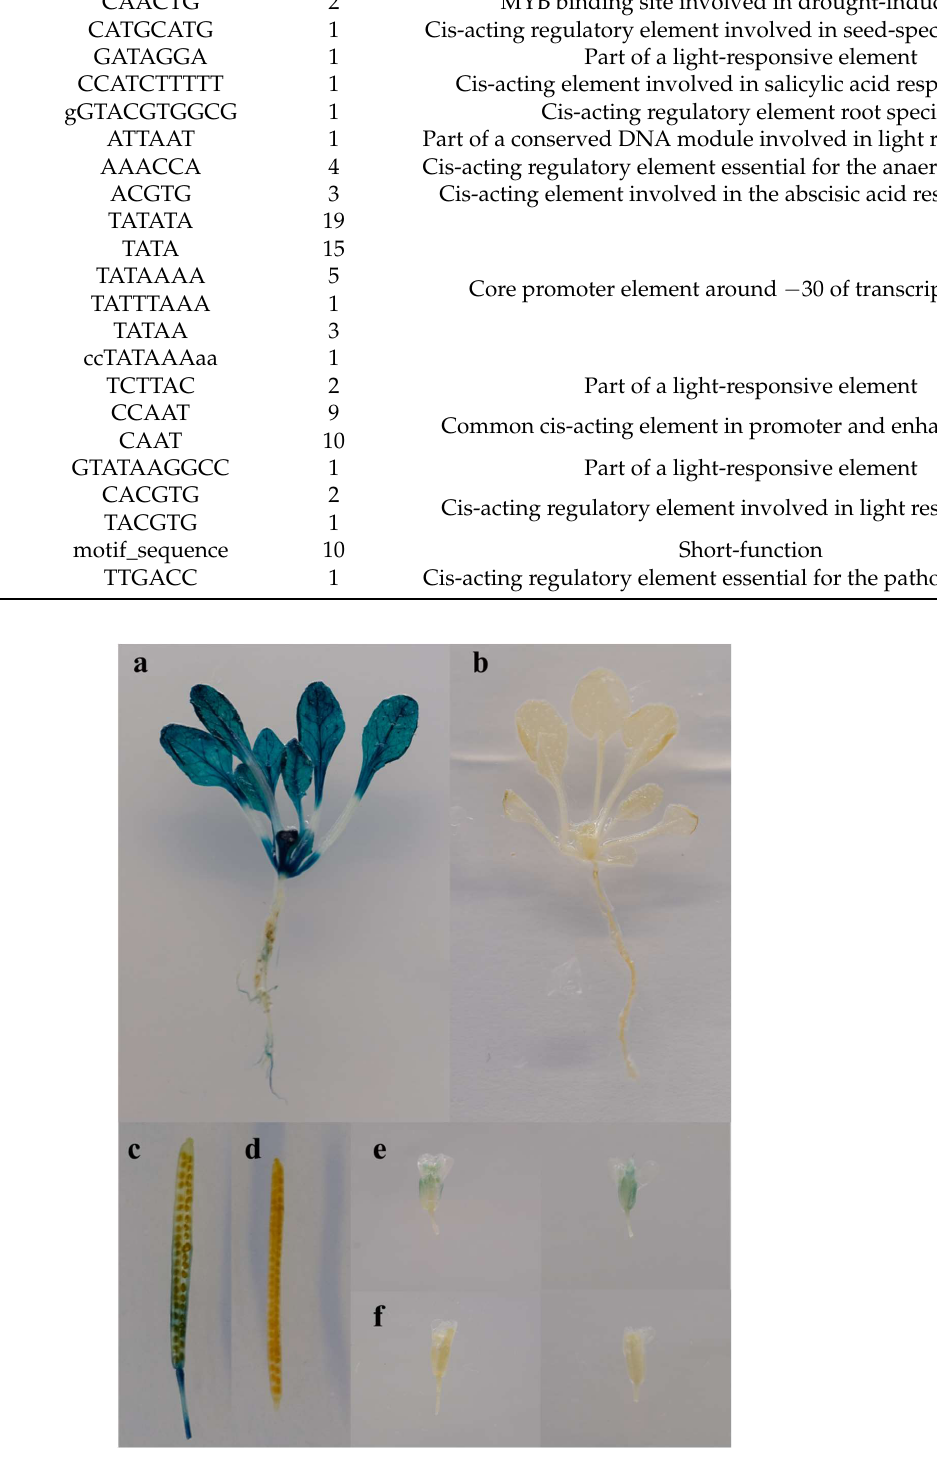
Figure 8. β−Galactosidase (GUS) staining of different tissues of Pro Brgolden :GUS transgenic Arabidopsis thaliana . Three−week−old seedlings of Pro Brgolden : GUS ( a ) and wild−type lines ( b ). Mature silique of Pro Brgolden : GUS ( c ) and wild−type lines ( d ). Flowers of Pro Brgolden : GUS ( e ) and wild−type lines ( f ).